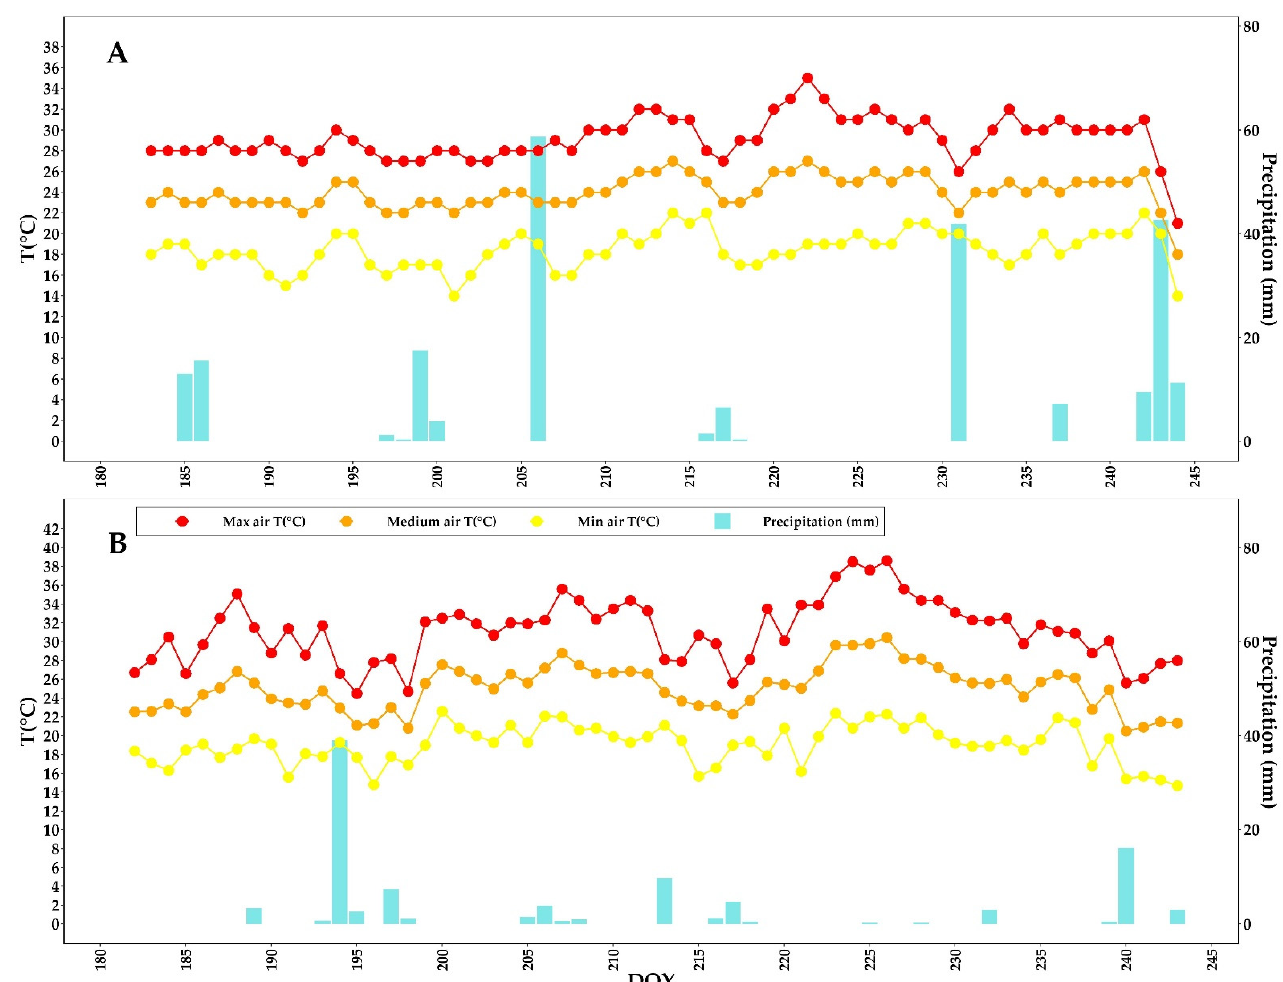
Figure 4. Meteorological conditions of the experiment location. Daily registrations of mean, maxi- mum, minimum air temperature ( ◦ C), and summation daily rainfall (mm) were measured from July to August (( A )-2020; ( B )-2021). The days were expressed in Julian Days (DOY). Daily registrations of mean, maximum, minimum air temperature ( ◦ C), and summa- tion daily rainfall (mm) were measured from July to August (2020–2021; Figure 4A,B). During July and August 2020, there were 14 days in which the maximum temperatures rose above 30 ◦ . The only day where the temperature rose to 35 ◦ was 9 August 2020 (222 DOY). While during July and August 2021, there were 38 days in which the maximum tempera- tures rose above 30 ◦ . The critical maximum temperatures were recorded on the